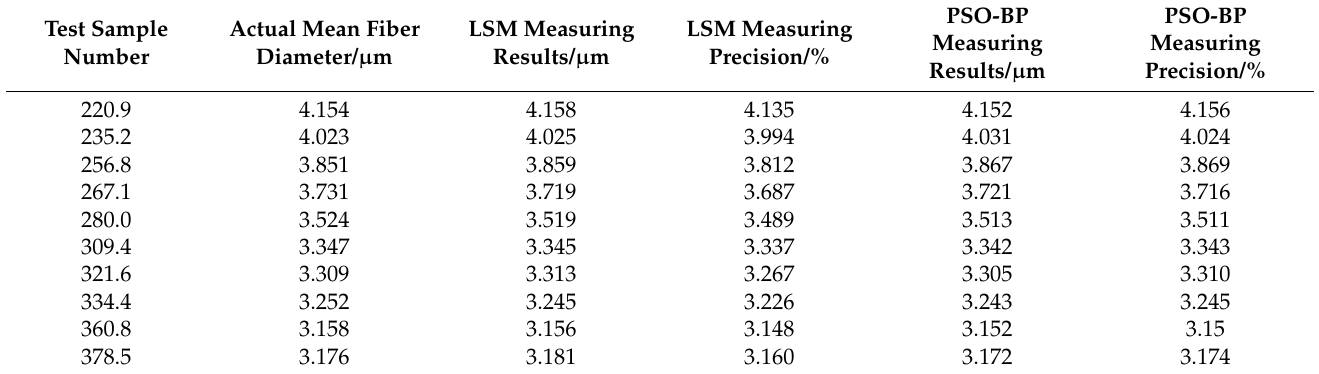
Table 2. Results comparison between LSM and PSO-BP model.